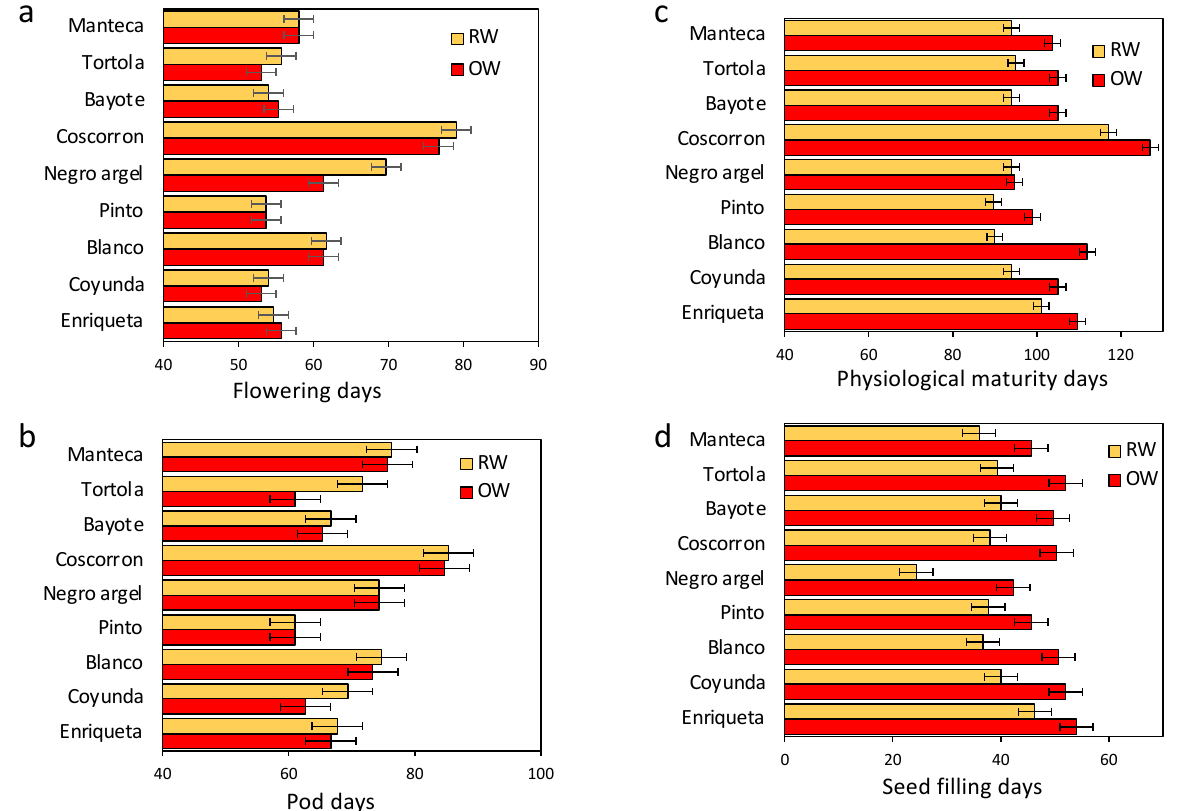
Figure 2. Effect of water stress on phenological traits for nine common bean Chilean landraces. Flowering days ( a ), pod days ( b ), physiological maturity days ( c ), and seed-filling days ( d ) under OW (red bar) and RW (orange bar). Bars represent the mean of three biological replicates, while the error bars indicate the least significant differences (LSD) value of the interaction water conditions by varieties at p <